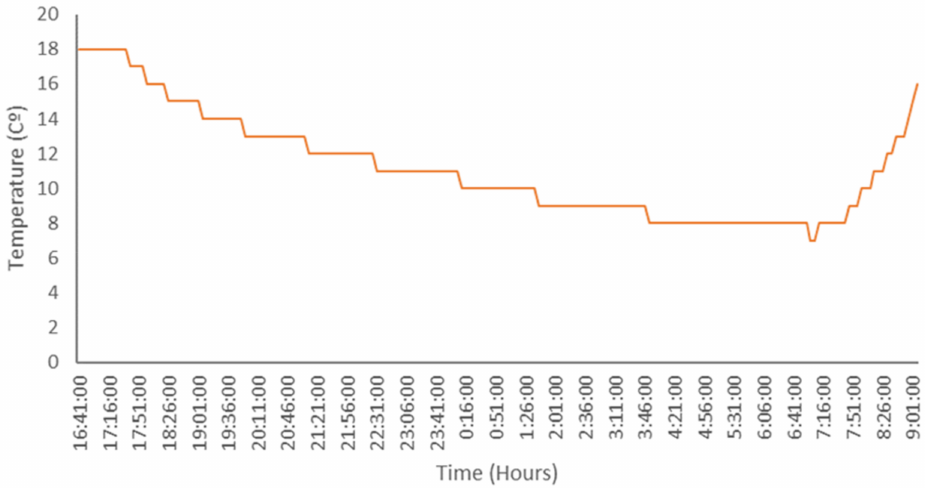
Figure 24. Monitored temperature throughout the night.